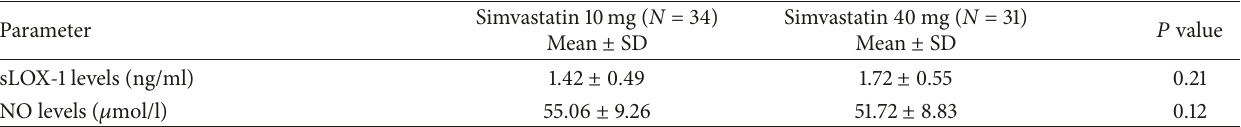
Table 2: Serum sLOX-1 and NO levels in patients with acute ischemic stroke at